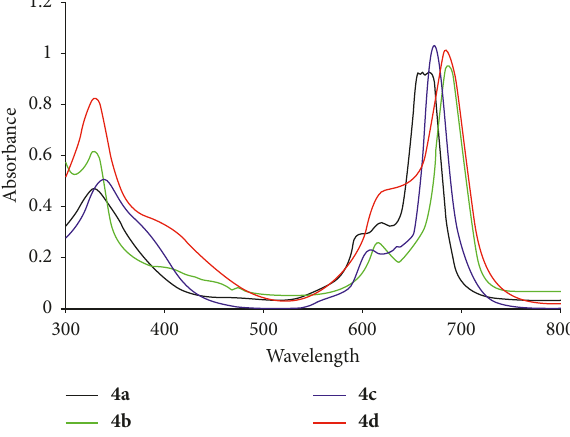
Figure 2: The absorption spectra of (qz)